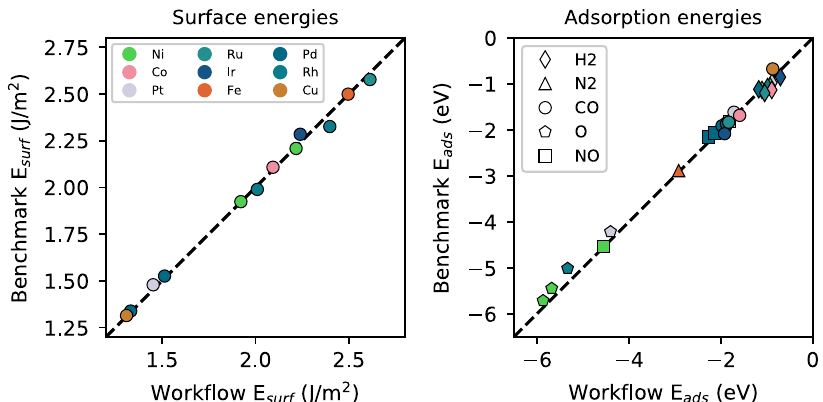
Fig. 1 Computational benchmarks, in which we compare results from our work fl ow to previously computed adsorption and surface energies. Surface energy benchmarks are from Tran et al . 6 Note that our work fl ow may not include surface reconstructions accounted for in the benchmarking set, which may account for small deviations. Calculated adsorption energy benchmarks are from Wellendorf et al . 10 and include chemisorption energies corresponding to materials and crystal facets featured in the CE27 database. Data for both chemisorption and surface energy benchmarks are from calculations using the PBE functional. A table is provided in the Supplementary Informtation that includes details on surface facets and data for surface and adsorption energies